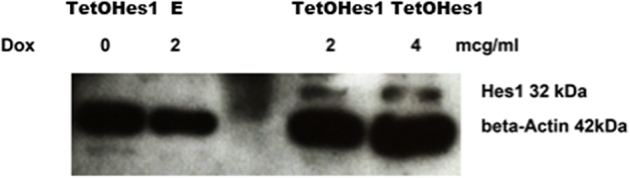
Hes1 protein expression is increased following doxycycline treatment in transduced Nphs2;rtTA podocytes. Representative image of a Western blot analysis of protein lysates from doxycycline-treated primary Nphs2;rtTA podocytes transduced with TetOHes1 and green fluorescent protein plasmids. Hes1 protein expression was increased following an increased dose of doxycycline in the TetOHes1 transduced podocytes and no Hes1 protein expression was observed in green fluorescent protein–transduced Nphs2;rtTA podocyte lysates postdoxycycline treatment.